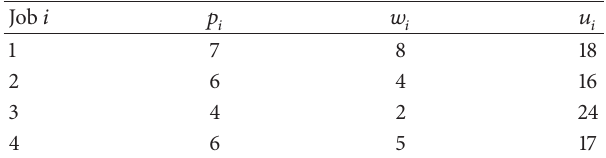
Table 1: Jobs’ parameters in Example 2. Table 2: Jobs’ parameters in Example